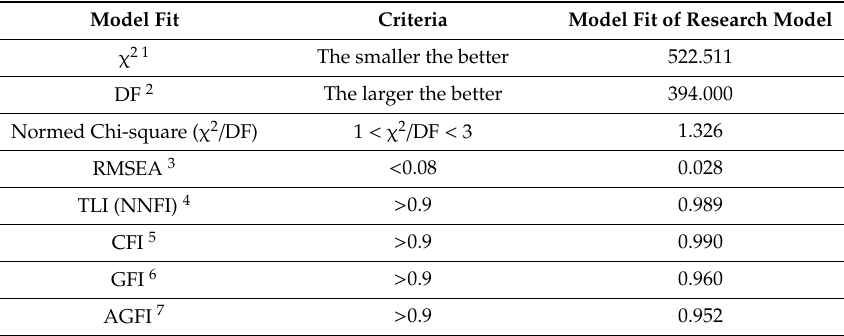
Table 6. Model fit